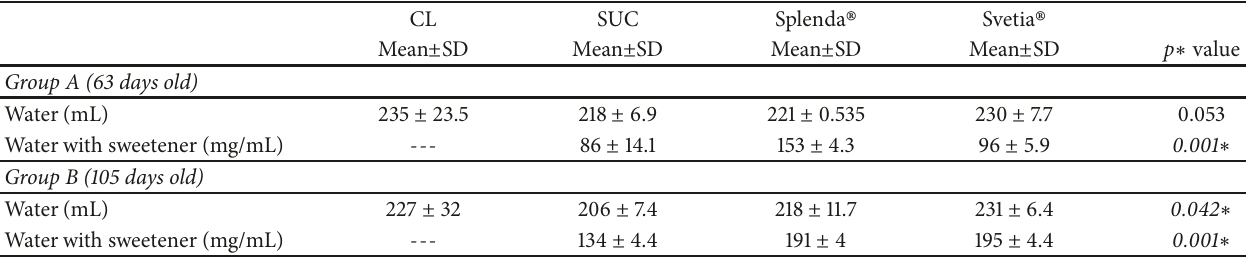
Table 2: Consumption of water with and without